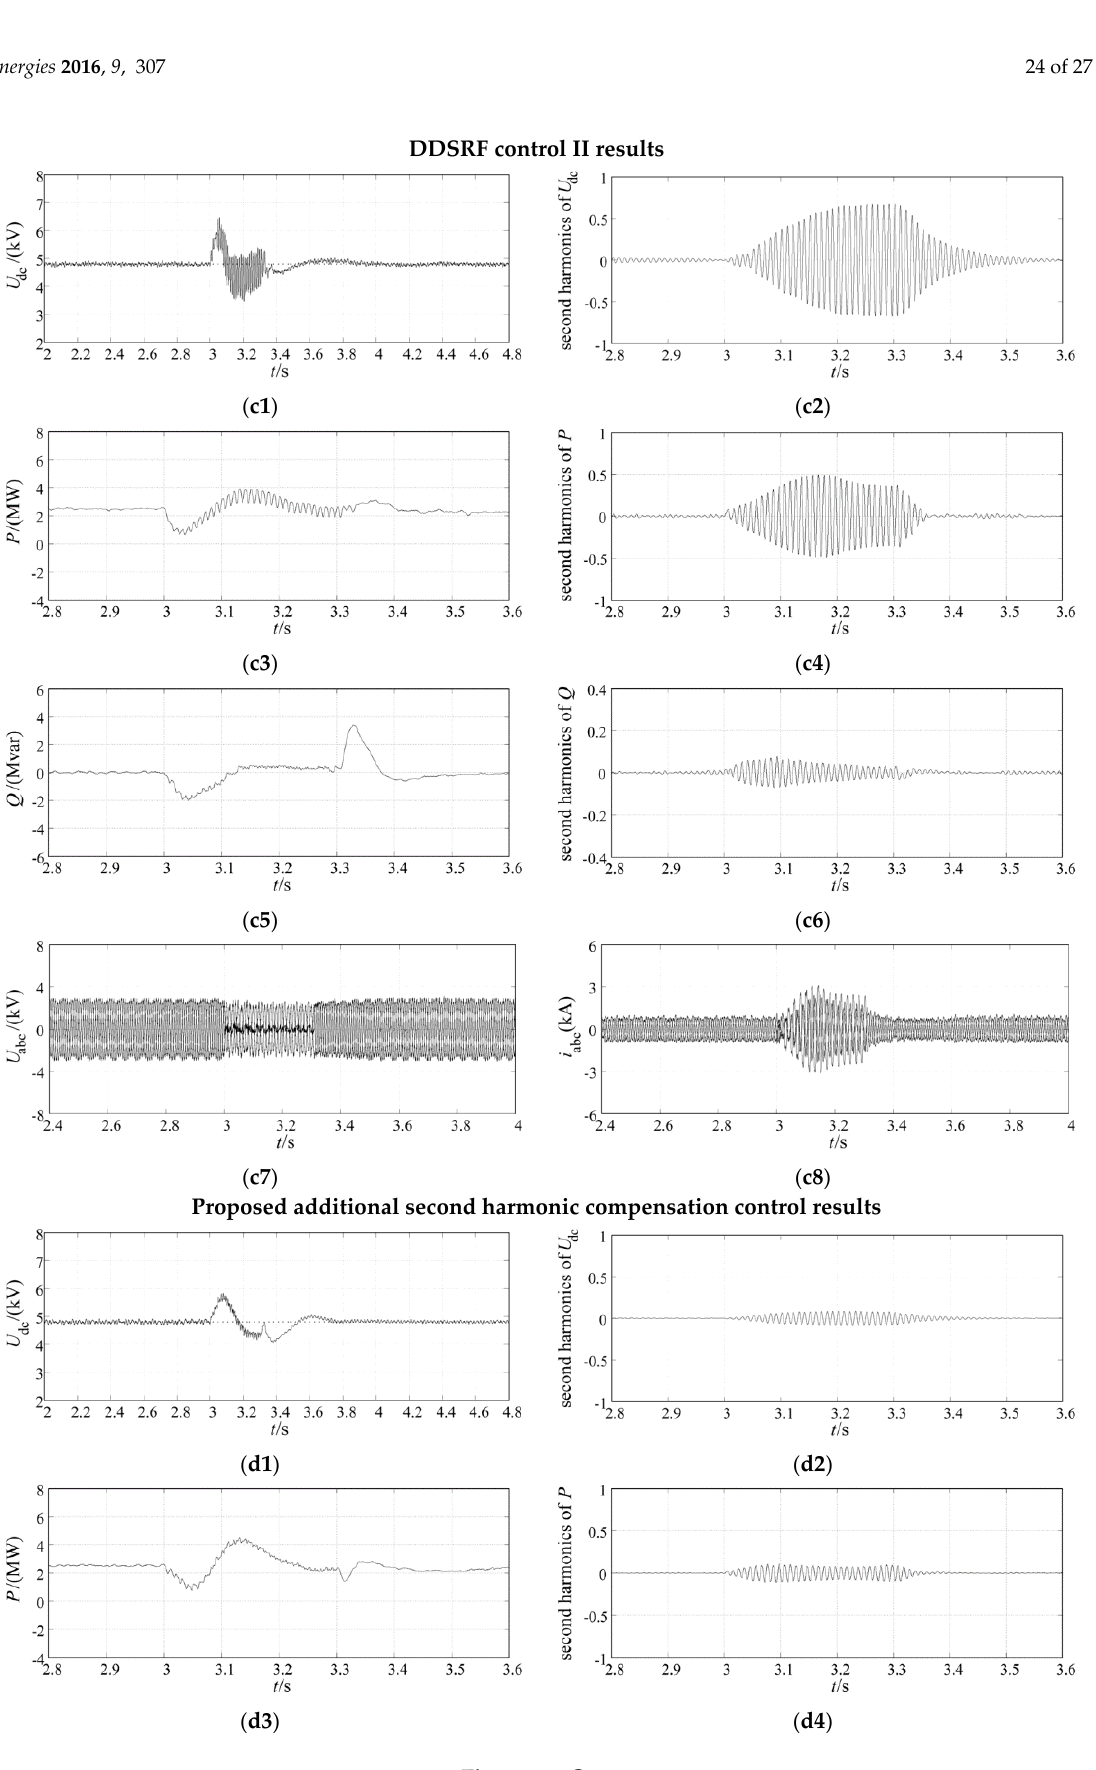
Figure 10. Cont. Figure 10.